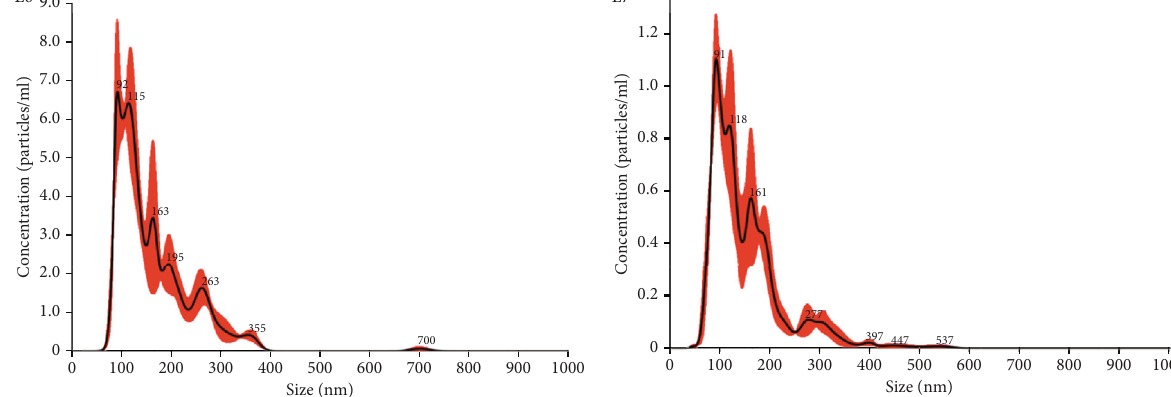
Figure 2: EV quanti fi cation using Nanosight Nanoparticle Tracking Analysis. MSC produced EVs in cell culture with a mean size of 163.3nm, with a homogenous EV